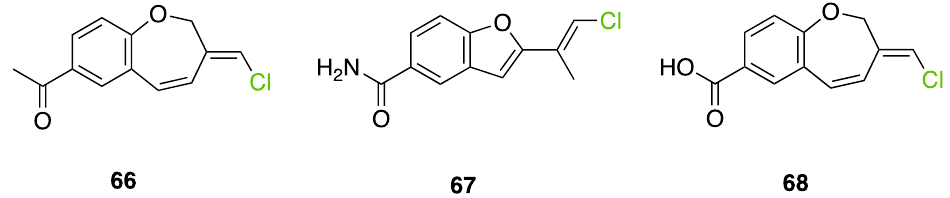
Figure 29. Some metabolites from cluster 5: pterulone ( 66 ), calocerin ( 67 ), and 2,3-dihydro-1-benzoxepin derivative 4a ( 68 ).